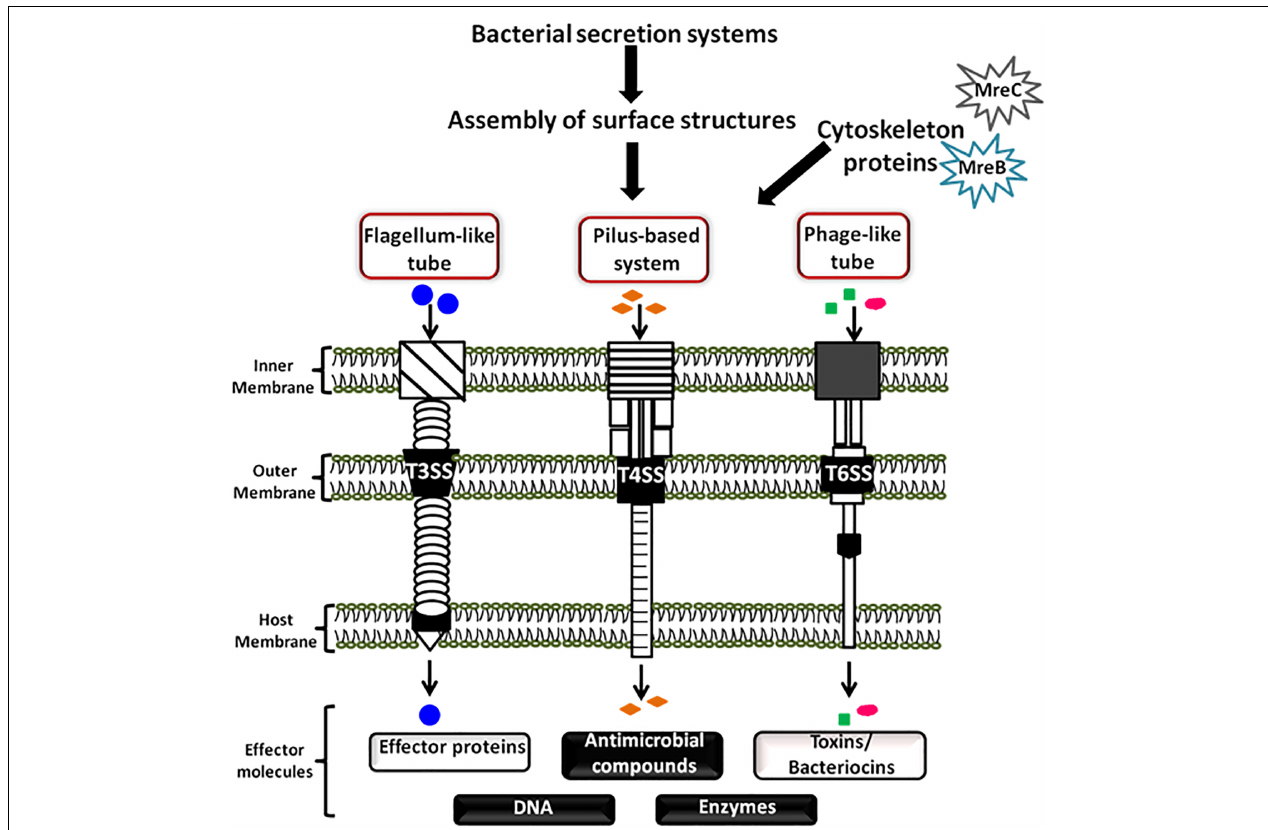
FIGURE 1 | Schematic diagram showing bacterial cell communication mediated by surface appendages and cytoskeleton proteins. Bacteria have evolved two broad ways of communication systems- the contact-independent and the contact-dependent signaling mechanisms. The figure is a schematic showing cellular communication mediated by the bacterial cytoskeleton proteins and contact-dependent signaling. The cellular apparatuses which play a major role in cellular communication through contact-dependent signaling are assembled by the secretion systems. These appendages transfer the secreted effector molecules (proteins, DNA, antimicrobial compounds, toxins, and enzymes) by intra and/or inter-species or even inter-kingdom